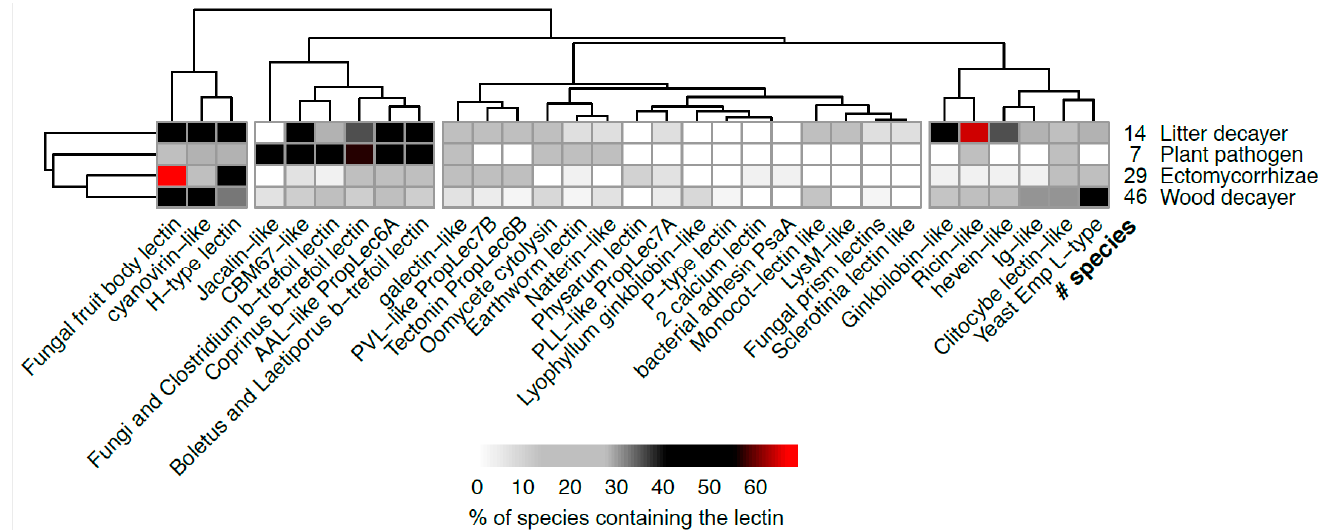
Figure 5. Occurrence of lectin classes in Agaricomycetes species grouped by lifestyle. Identified lectins are at least 25% similar to the reference. Ubiquitous lectins were filtered out. Only ecological groups represented by more than 5 species are represented.